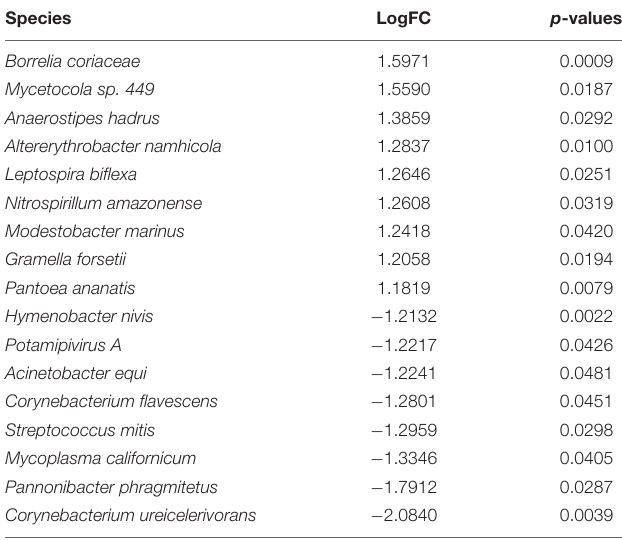
TABLE 1 | The species identified by metagenomeSeq.